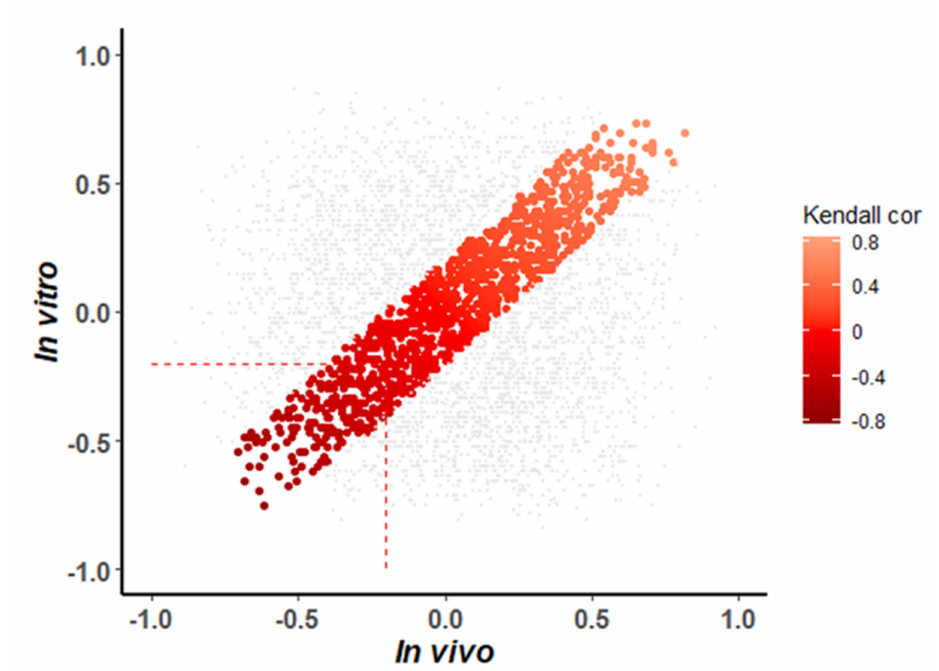
Figure 7. Correlation of miRNAs with their target genes for in vitro and in vivo experiments. Each dot represents a miRNA–mRNA interaction. The values of the x -axis are the Kendall correlation coefficients for the in vivo data; the values of the y-axis are the correlation coefficients for the in vitro data. Highlighted by red gradient colour are miRNA–mRNA interactions with similar correlation coefficients in both in vivo and in vitro, i.e., with a difference in correlation coefficient <0.2. Dashed lines indicate the threshold of negative correlation for